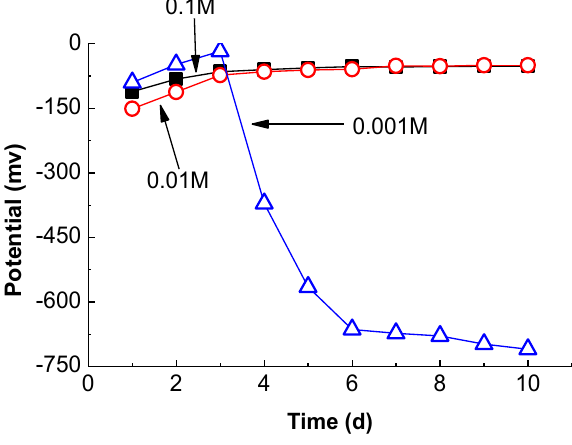
Figure 4. Effect of OH − concentration on the OCP.